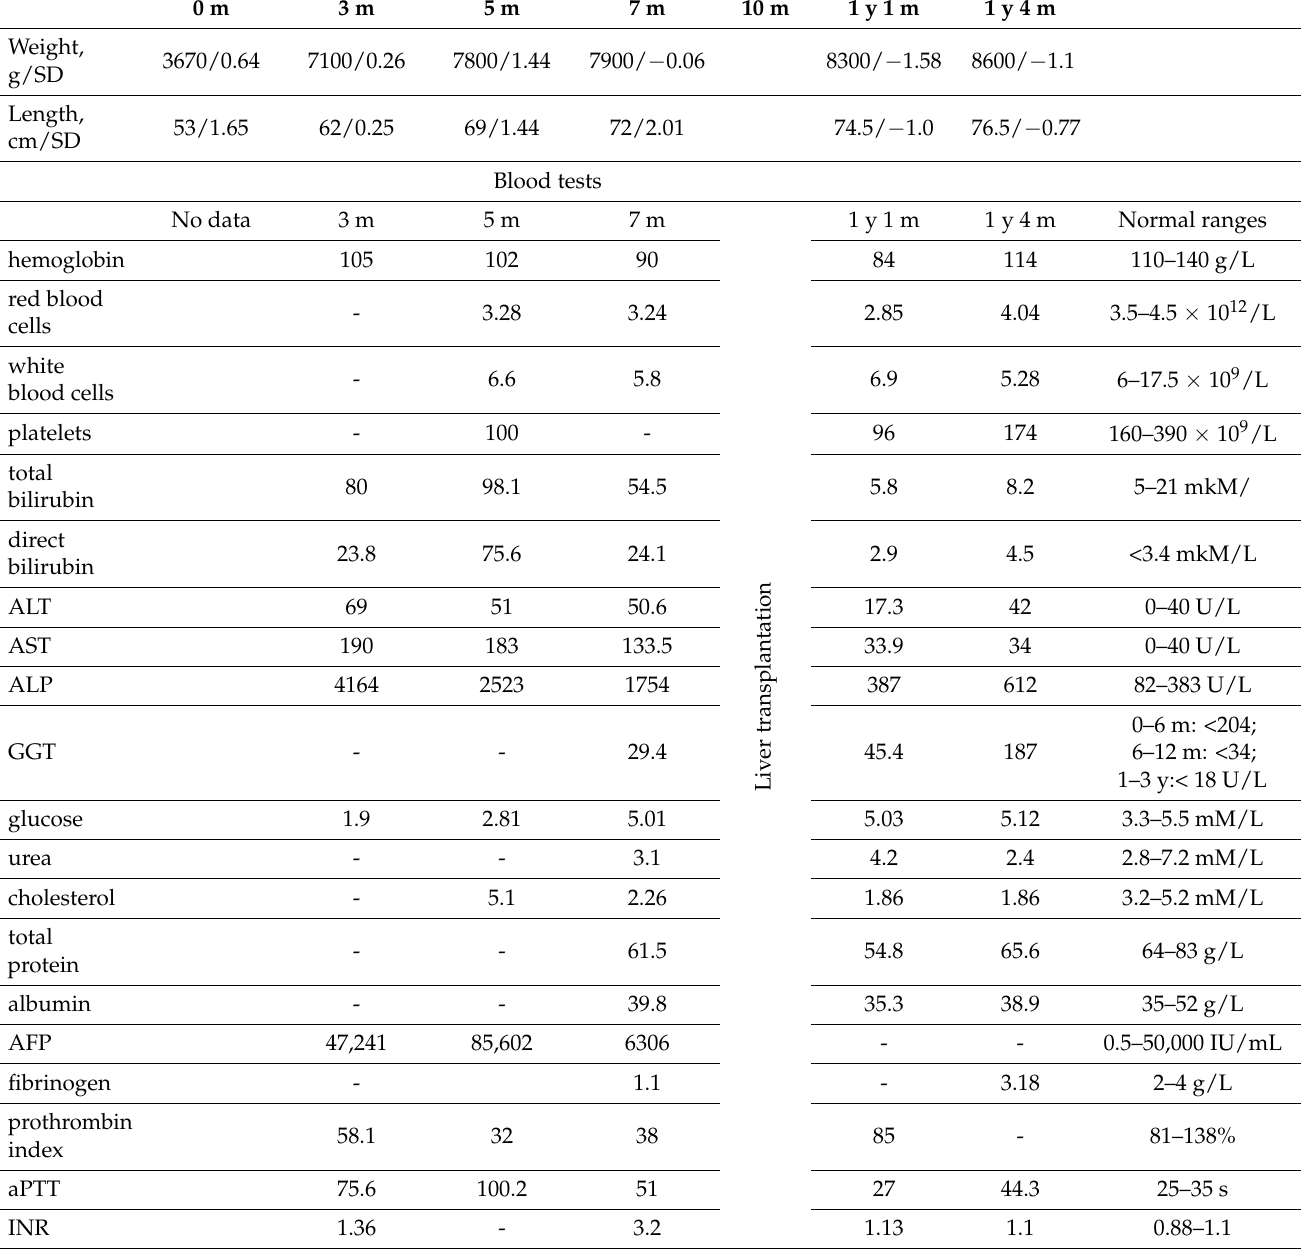
Table 1. Anthropometric parameters and laboratory data (from birth to one year and four